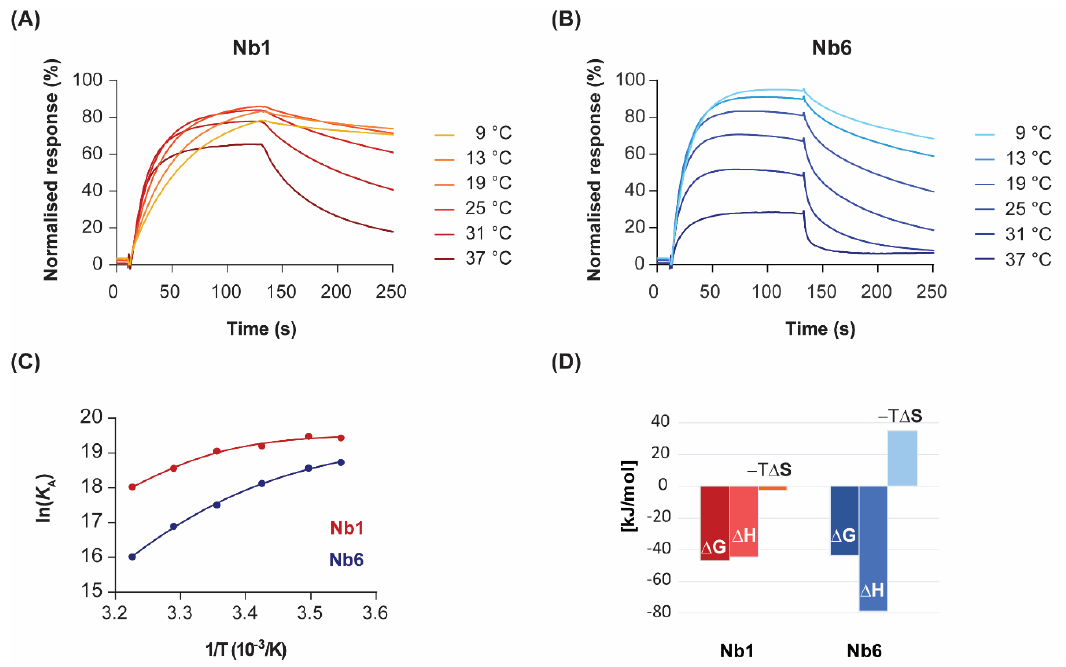
Figure 2. Temperature dependence of binding kinetics and thermodynamic characterisation. Nb1 ( A ) and Nb6 ( B ) were injected over immobilised EGF at the indicated temperatures. For clarity, only sensorgrams of a single analyte concentration (70 nM) are shown. ( C ) Van’t Hoff plots representing the variation of the equilibrium association constants ( K A ) with the inverse of temperature. Data points were fitted to a second-order polynomial equation from which ΔG, ΔH, ΔS and ΔC p values were determined, following Equation (3). ( D ) Enthalpy (ΔH) and entropy (−TΔS) contributions to the free energy of binding (ΔG) for each Nb at 25 °C.